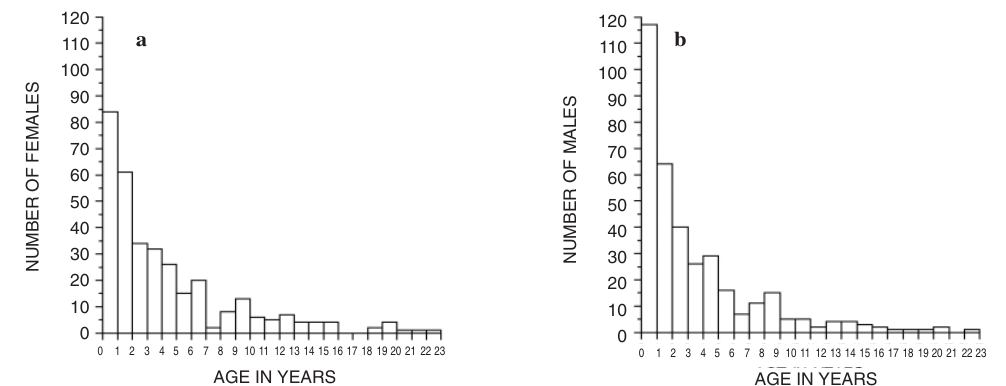
Fig. 4. Age frequency distribution for stranded and bycaught